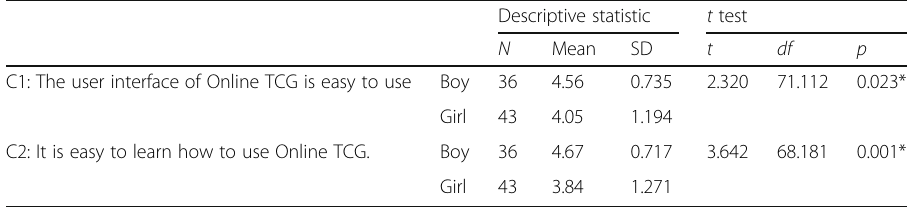
Table 17 Independent t test result for students ’ perceived ease of use of the game (gender difference